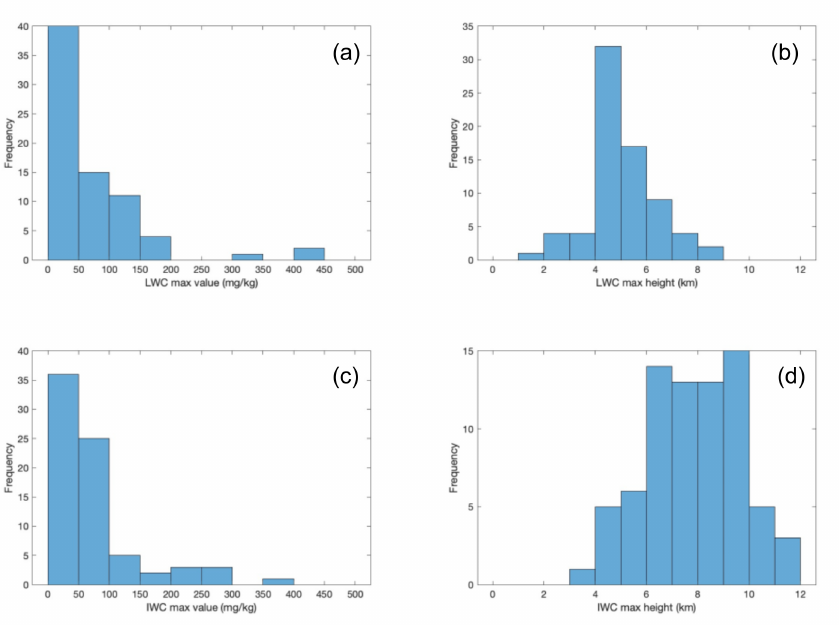
Figure 6. Satellite-derived cloud data for the Al Ain events considered. Frequency of ( a ) liquid water content (LWC) maximum and ( c ) ice water content (IWC) maximum for all rain events. Height of maximum LWC maximum ( b ) and IWC maximum ( d ) for all rain